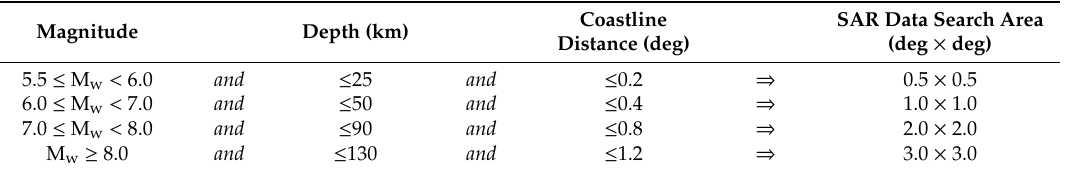
Table 1. Earthquake magnitude, depth, and coastline distance classes and the corresponding SAR data search area